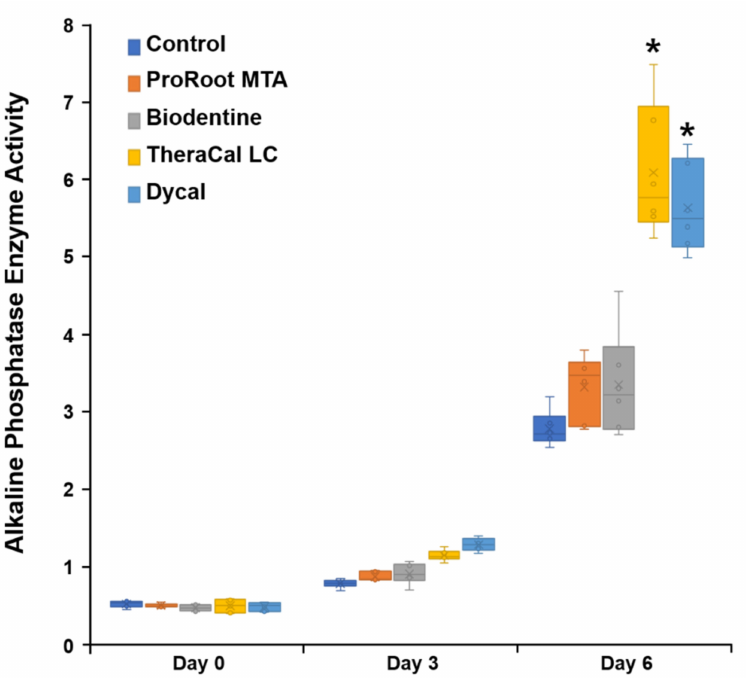
Figure 4. Alkaline phosphatase (ALP) enzyme activity in hDPSCs incubated with various pulp capping materials. * Statistically significant difference between experimental and control groups.